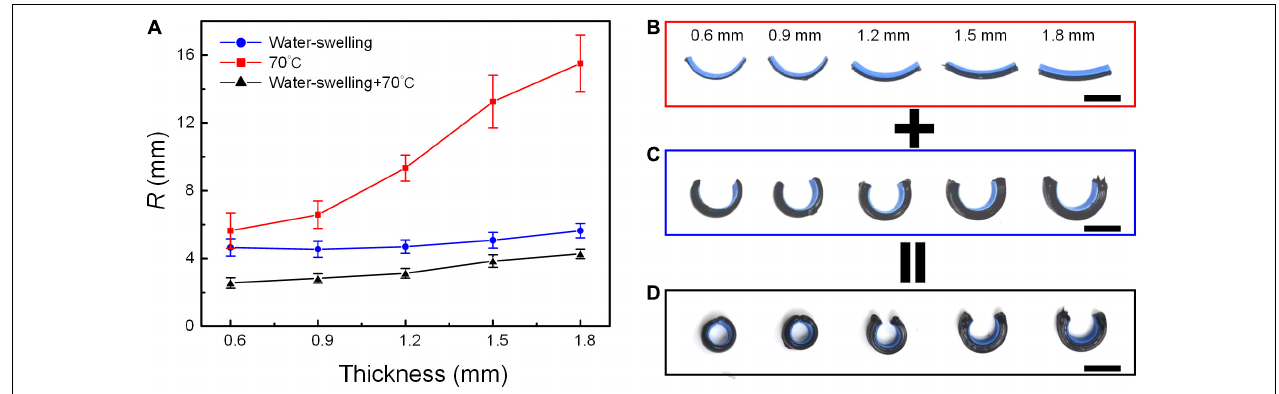
FIGURE 5 | The effect of the PU layer thickness printed in the radial direction on bending deformation of the PU-SMPVC bilayer structures. (A) Bending radius as a function of PU layer thickness in 70 ◦ C, room temperature water and 70 ◦ C water. Images of bending deformation of the PU-SMPVC bilayer structures in 70 ◦ C (B) , room temperature water (C) and 70 ◦ C water (D)